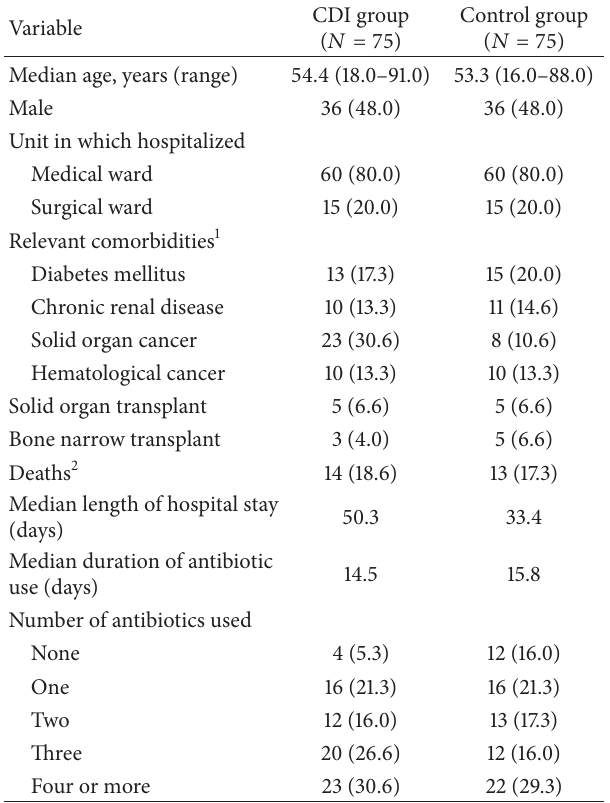
Table 1: Baseline characteristics of patients with Clostridium difficile colitis and controls with hospital-acquired diarrhea of other